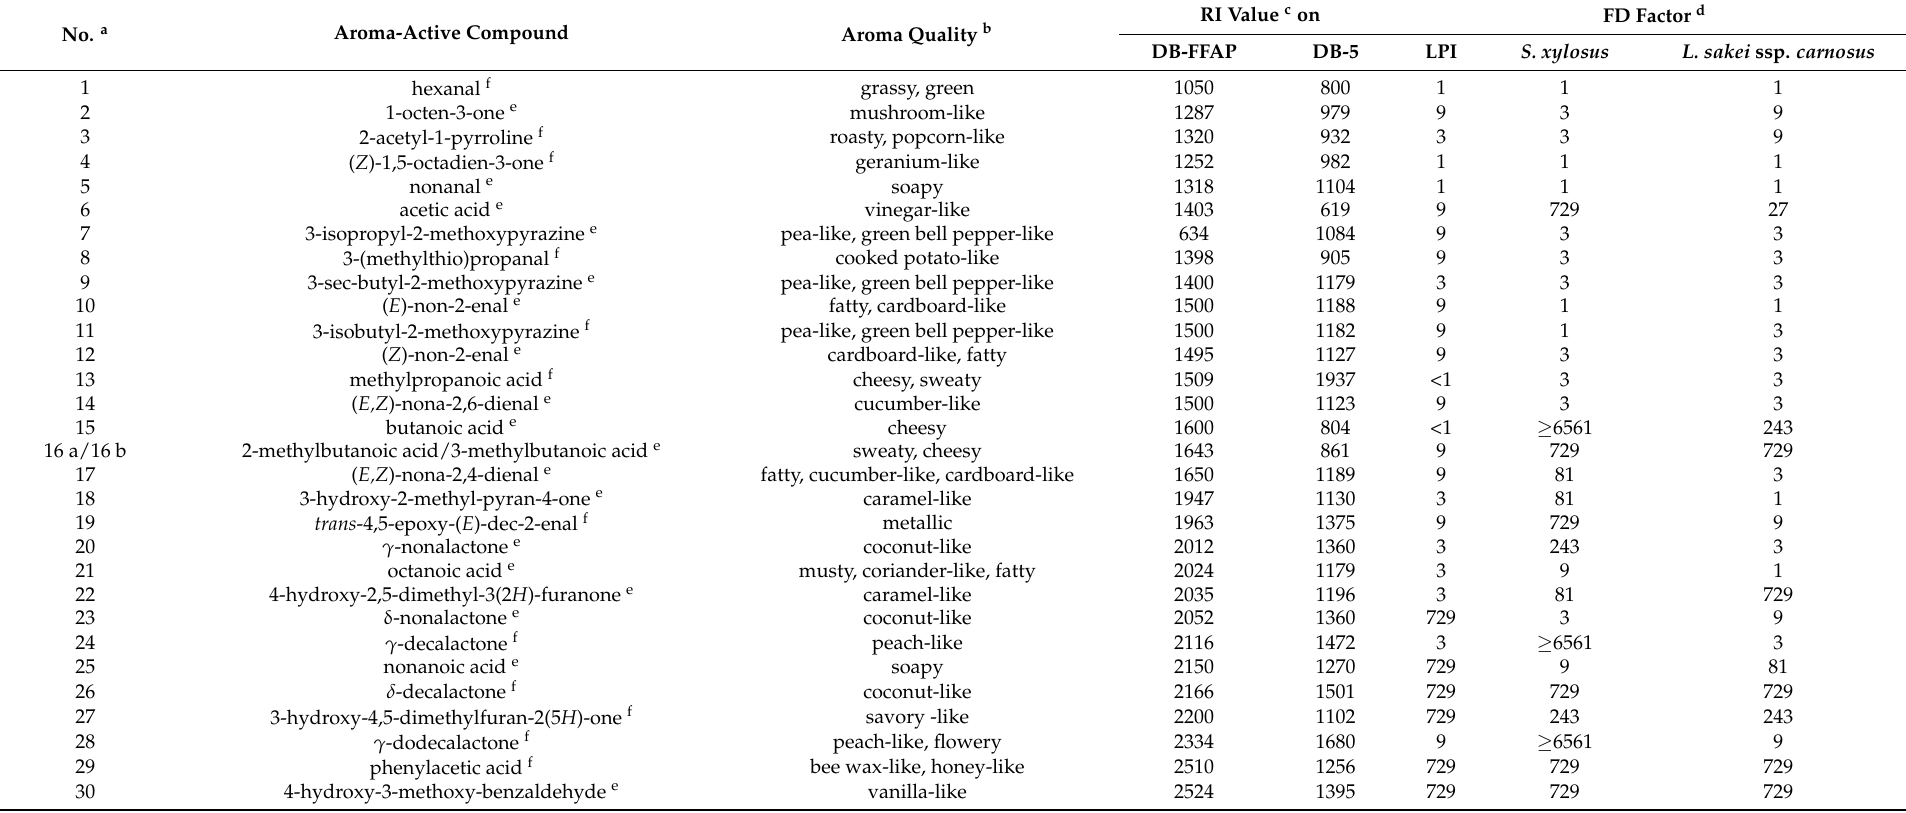
Table 1. Aroma-active volatile organic compounds and their corresponding olfactometric and chromatographic parameters identified in aroma distillates obtained from lupin protein isolates (LPI) and with S. xylosus (DSM 20266) and L. sakei ssp. carnosus (DSM 15831) fermented